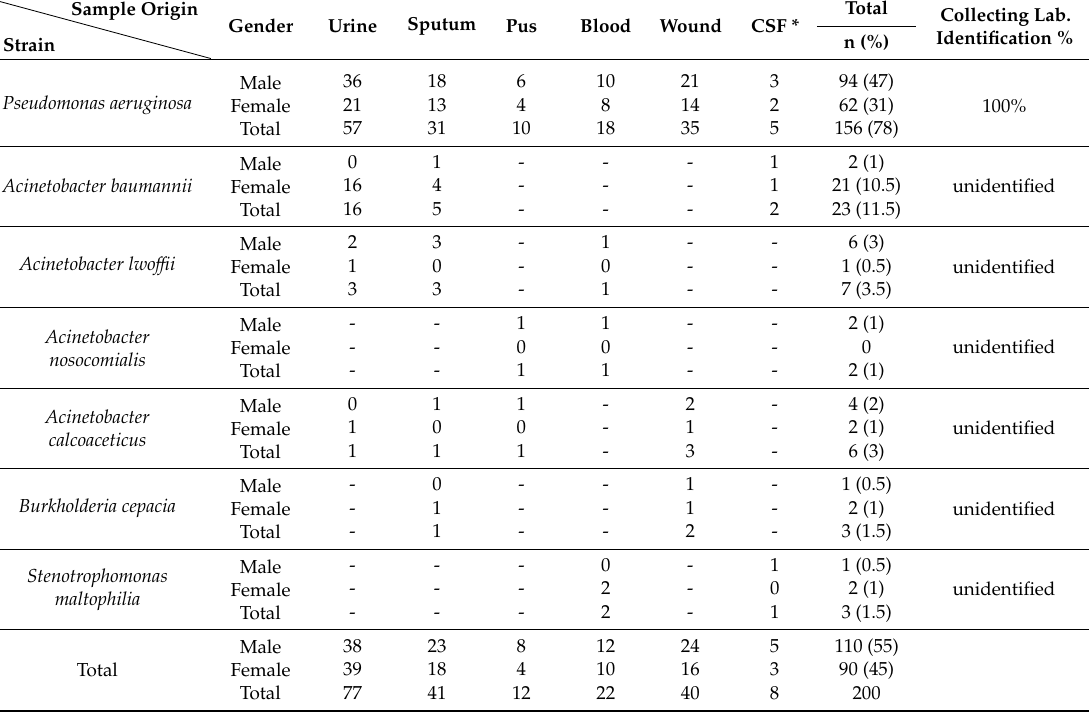
Table 1. Distribution of Gram-negative non-fermentative isolates according to sample source and patient gender ( n =